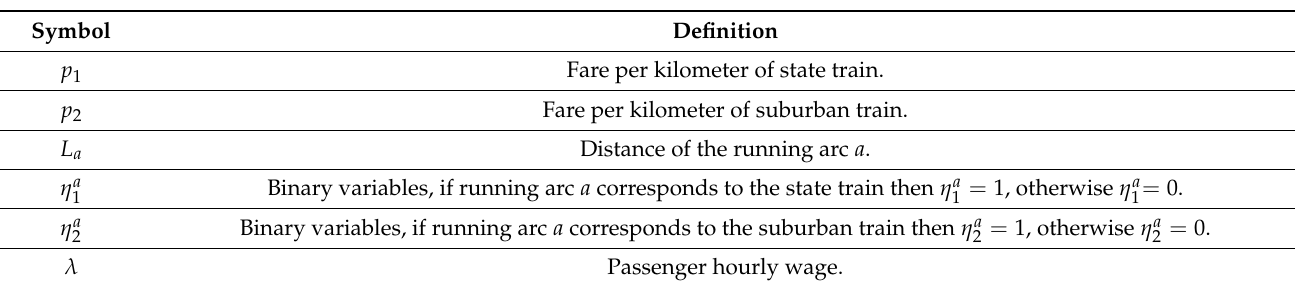
Passenger hourly